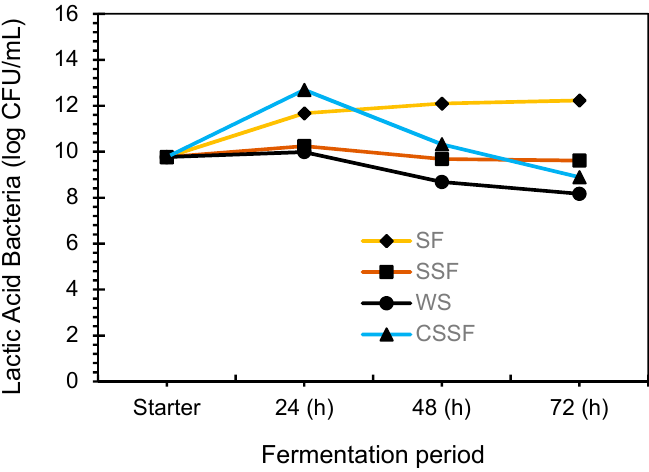
Figure 3. Growth curve of lactic acid bacteria during simultaneous saccharification and fermentation (SSF) ( ∎ ), saccharification then fermentation (SF) ( ◆ ), addition of CaCO 3 (CSSF) ( ▲ ), and without of saccharification (WS) ( ● ) .